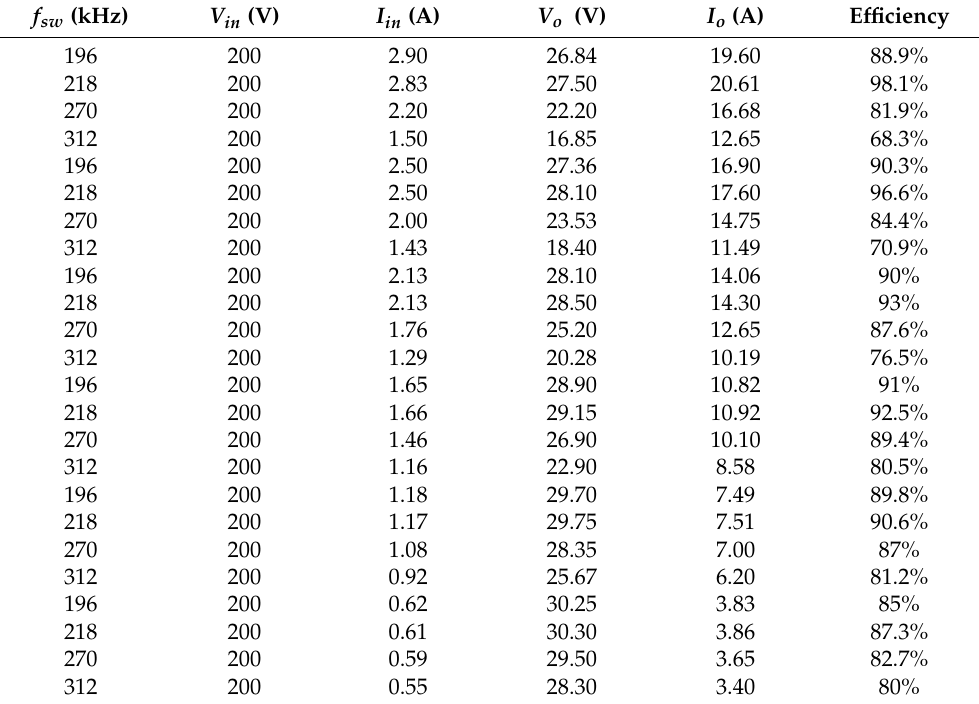
Table 3. Conventional frequency modulation (FM) efficiency